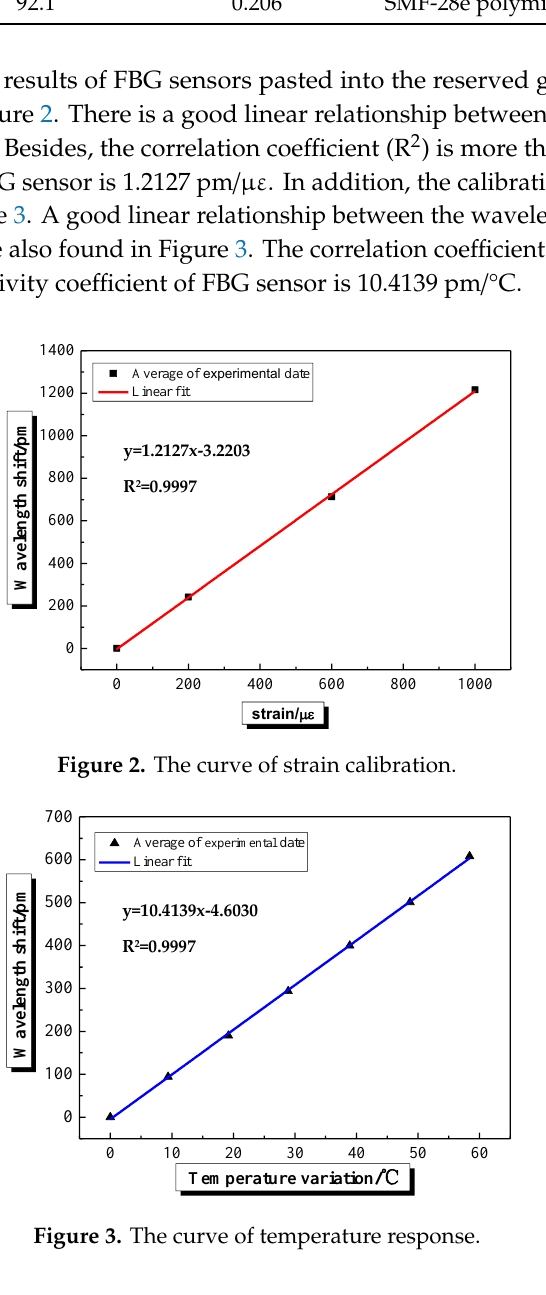
Table 1. Parameters of FBG sensors.